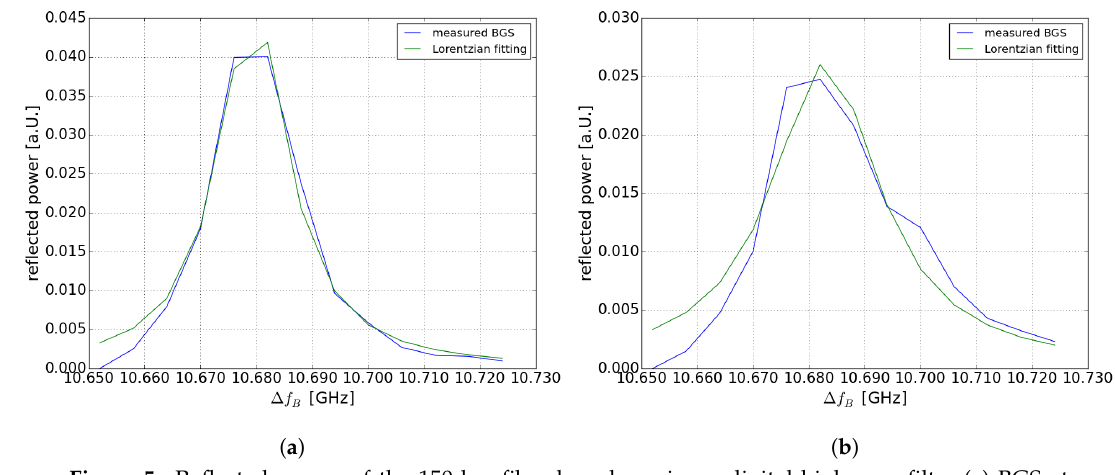
Figure 5. Reflected power of the 150-km fiber loop by using a digital high-pass filter ( a ) BGS at 74.200 km at room temperature ( b ) BGS at 74.156 km within the heated